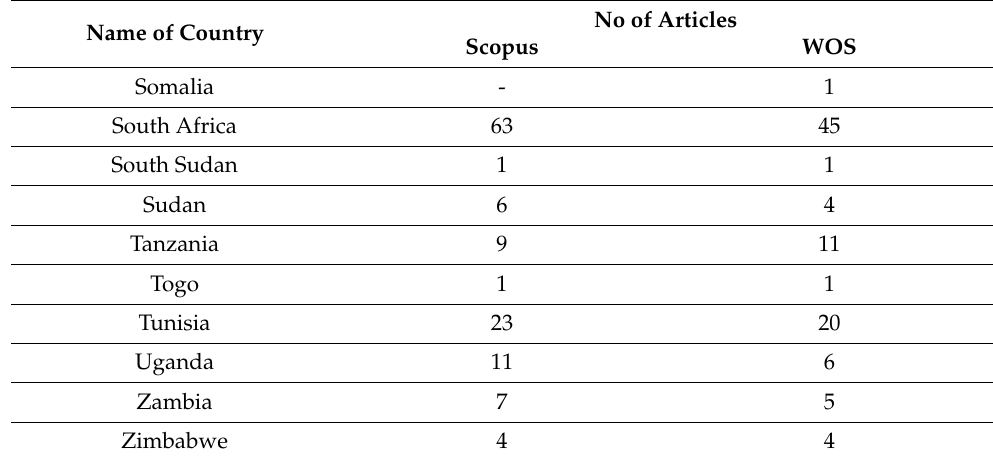
Table A1. Cont. Name of Country